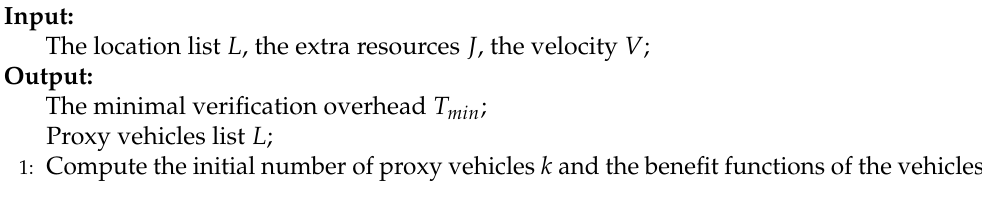
Algorithm 1 The Proxy Vehicles Selection